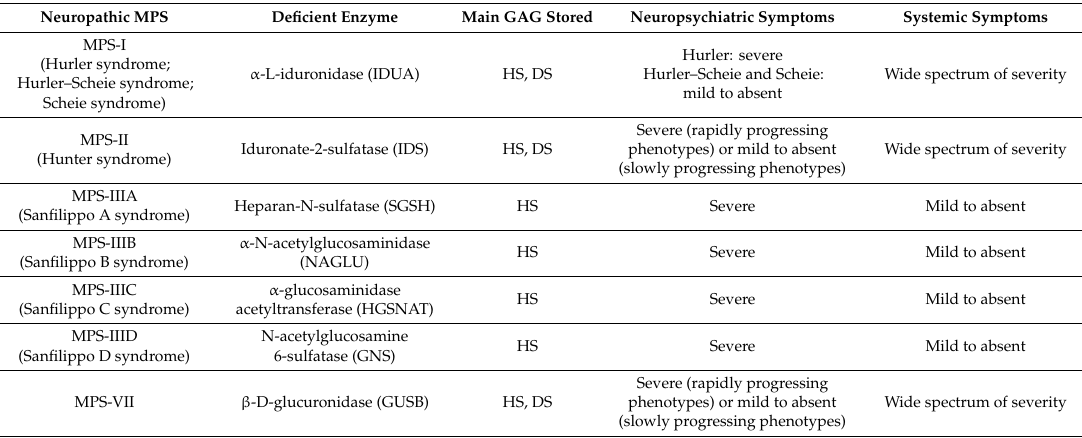
Table 1. Biochemical classification of neuropathic mucopolysaccharidoses (MPS) and corresponding symptom severity. GAG, glucosaminoglycan; HS, heparan sulfate; DS, dermatan sulfate. Neuropathic MPS Deficient Enzyme Main GAG Stored Neuropsychiatric Symptoms Systemic Symptoms